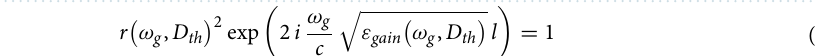
1 TLS , where (cid:31)